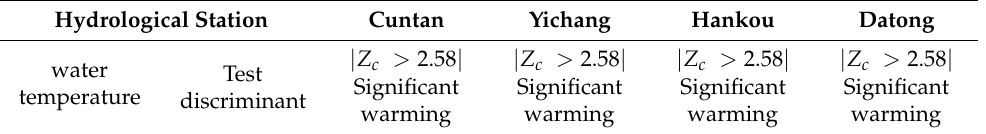
Table 1. Results of M-K analysis of the flow and water temperature variation trend at the main hydrology stations in the Yangtze River.